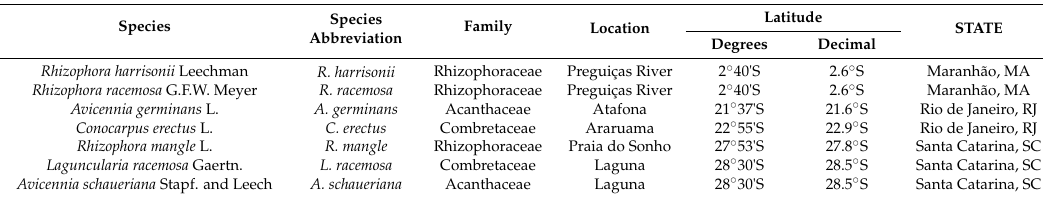
Table 1. Brazilian mangroves species and their respective distribution limits from north to south (summary adapted from